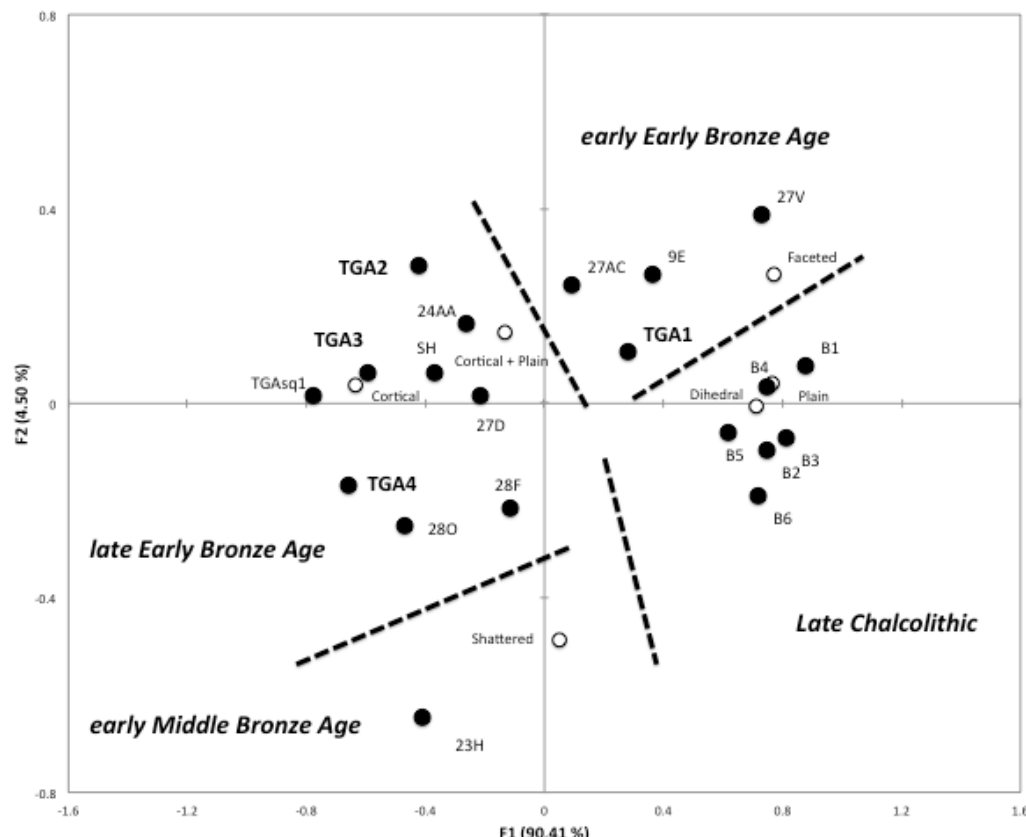
Figure 7. Results of a correspondence analysis of flake platform types from Tell Ghanem al-Ali and selected survey sites. For the legends, please see